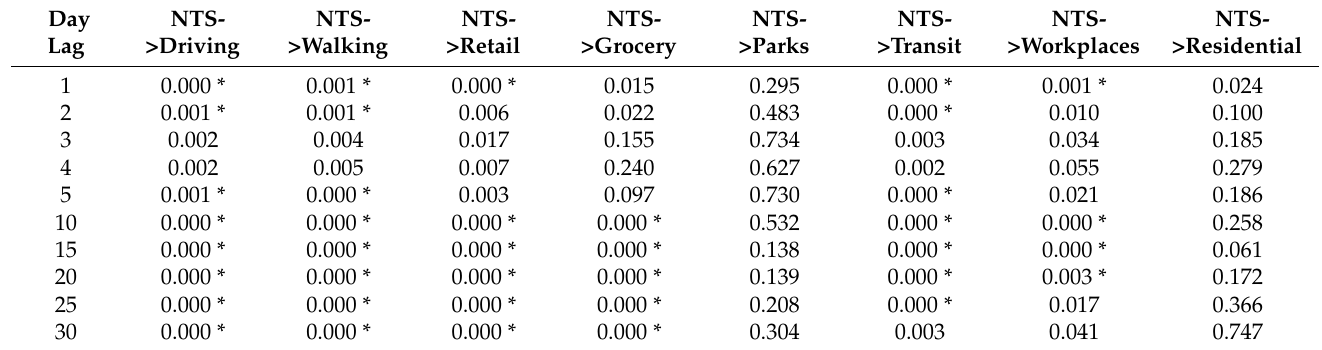
Table A8. New_tests_smoothed (NTS), Granger-cause mobility variables, and p -values in day lags in Portugal.